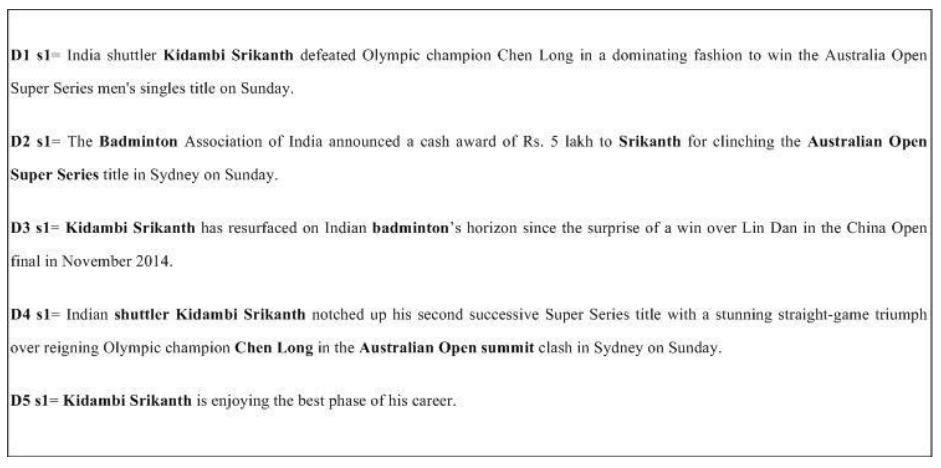
Figure 2. Example sentences from five documents. Table 2 shows the five news documents first sentence matching according to keyphrases. Table 2. The five news documents’ first sentence-matching according to keyphrases.